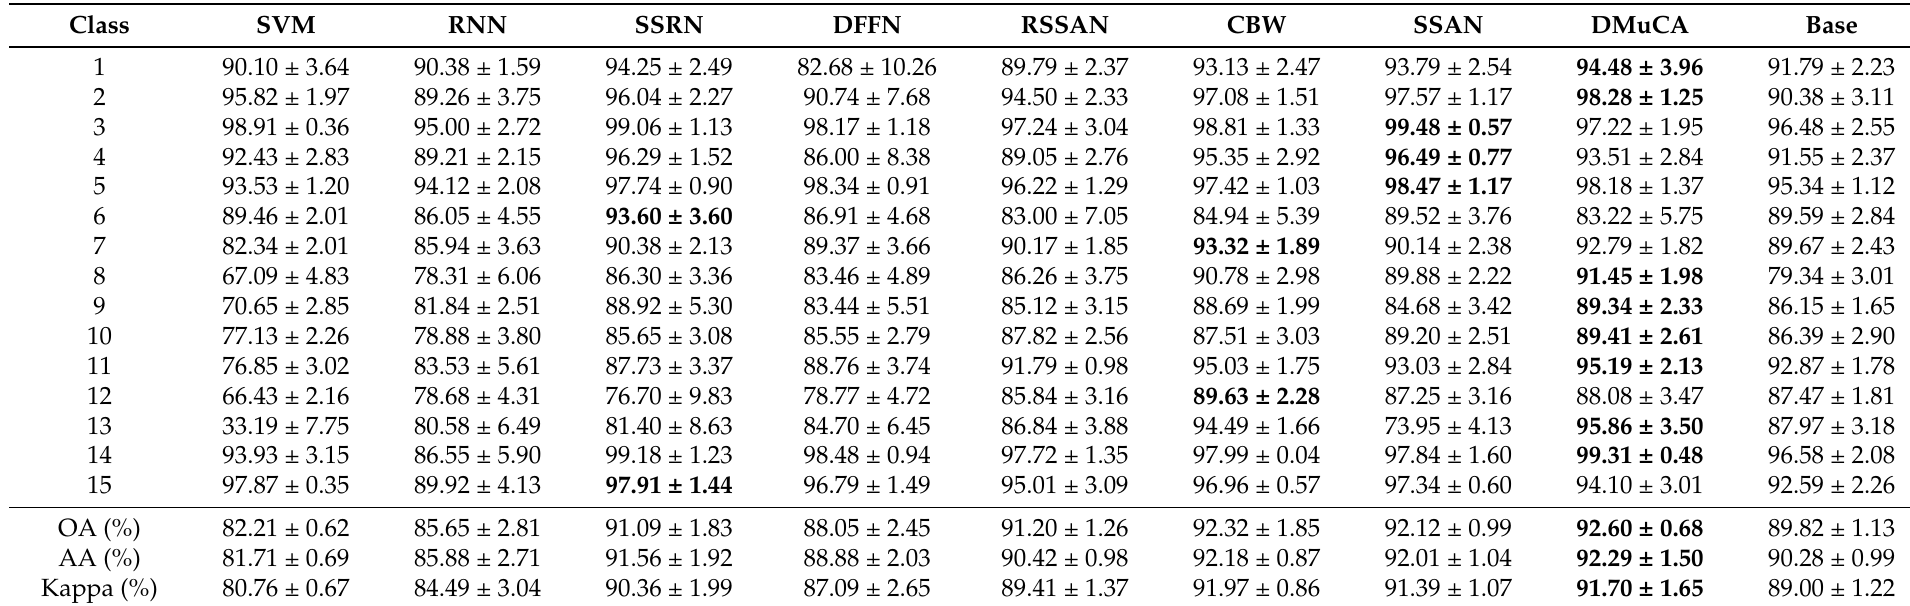
Table 12. Testing results over UH dataset with 3% samples per class for model training. The best results are highlighted in bold